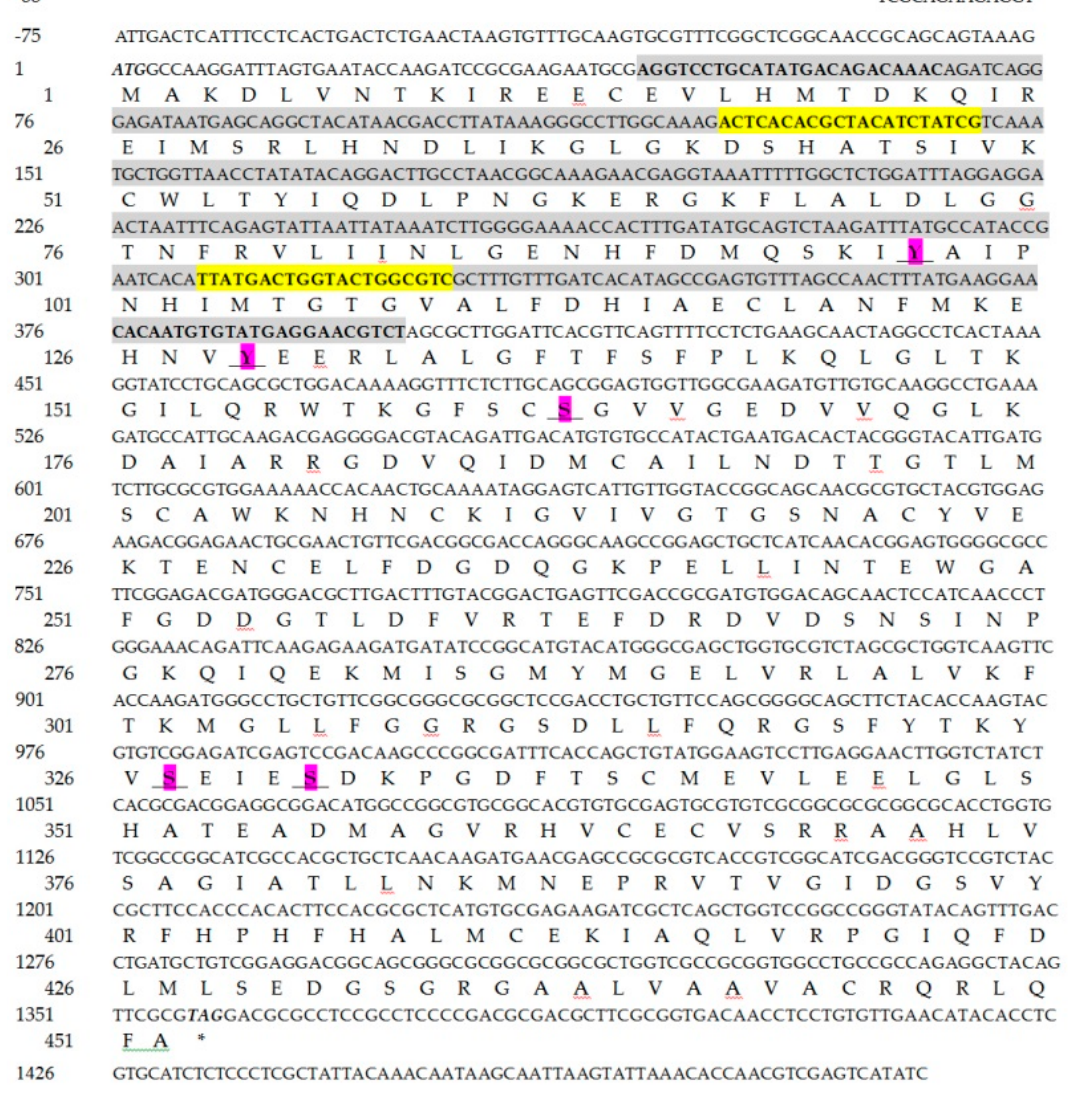
Figure 1. Nucleotide and deduced amino acid sequences of CmHK . Start and stop codons are indicated by bold typeface and italic. One conserved domain of CmHK used for dsRNA synthesis (44–398 bp) is indicated as grey. Phosphorylated sites are underlined in bold and pink. Primers of ds CmHK synthesis are shaded in bold, while RT–qPCR primers are indicated by bold and yellow shading.